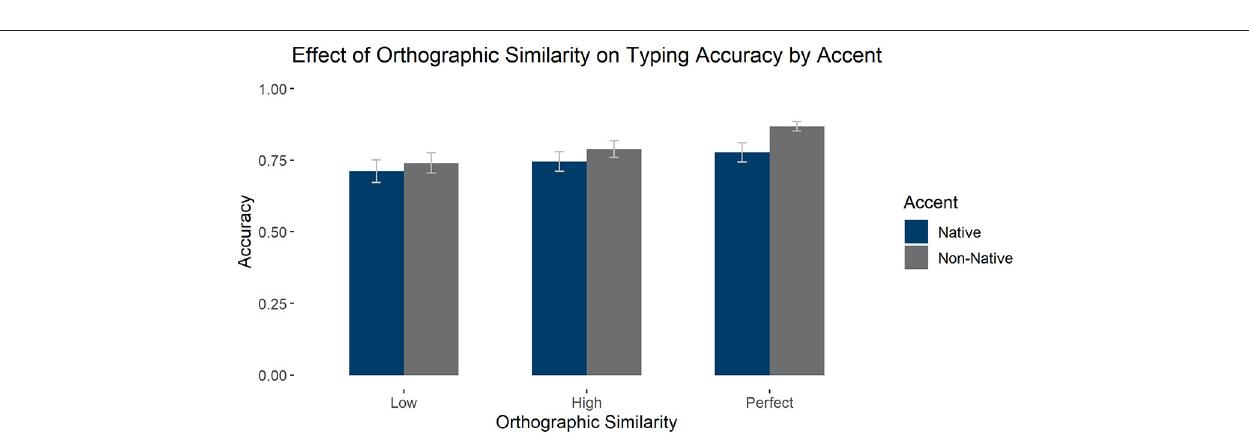
FIGURE 7 | Average accuracy in the typing task for high phonological similarity words by accent and orthographic similarity condition. Error bars mark 95% confidence